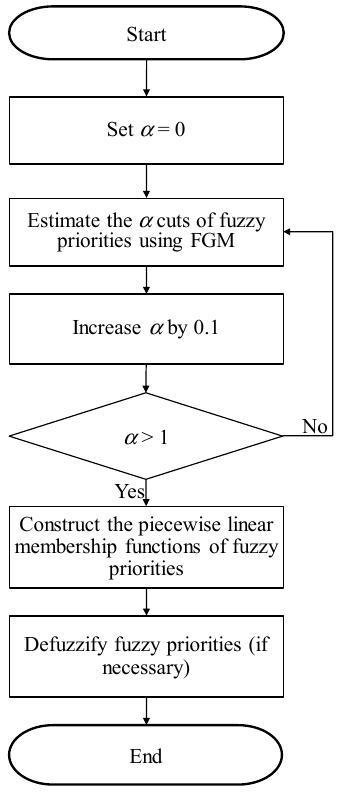
Estimate the α cuts of fuzzy priorities using FGM